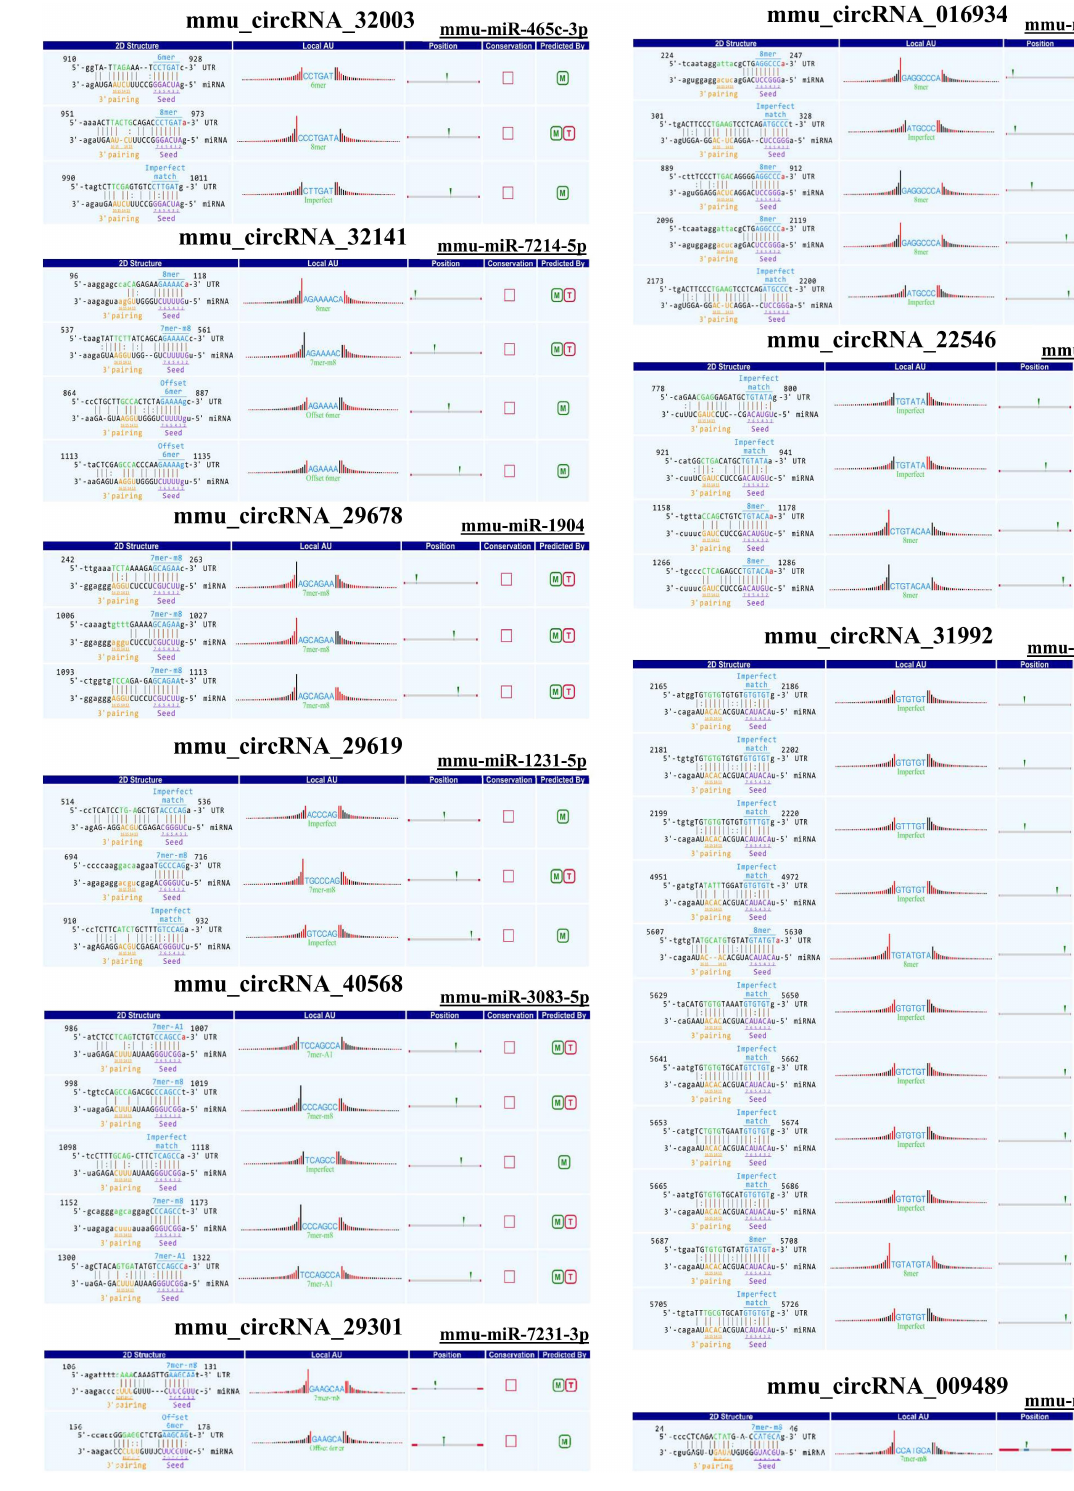
FIGURE 4 | Sequence pairing predictions for circRNAs and miRNAs. Seed sequence matching predicted the direct interaction of the abovementioned circRNAs with their related miRNAs.